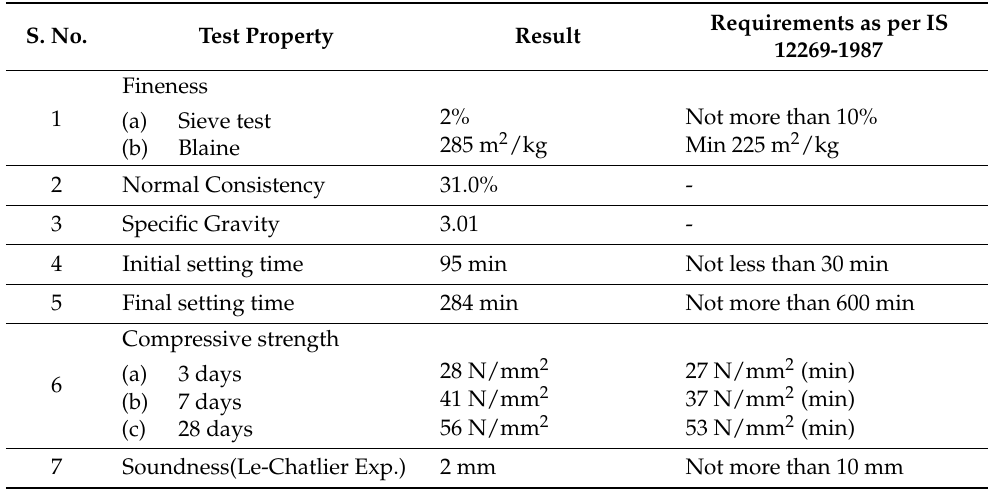
Table 1. Physical properties of Portland cement.